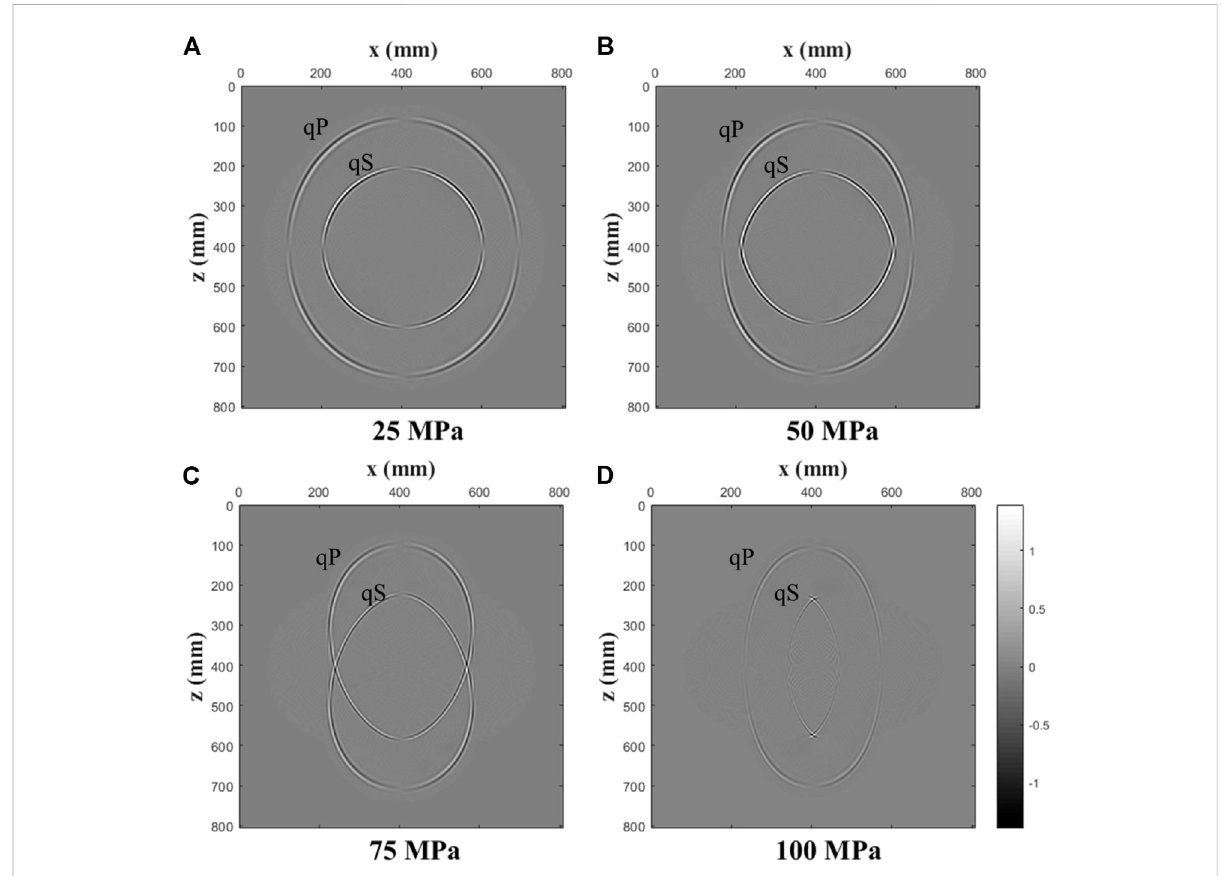
FIGURE 7 Coupledwave fi eldsnapshotsofthex-componentoftheparticlevelocityatt=0.1 msforvariousuniaxialstresses( (A) :25MPa; (B) :50MPa; (C) : 75 MPa; (D) : 100